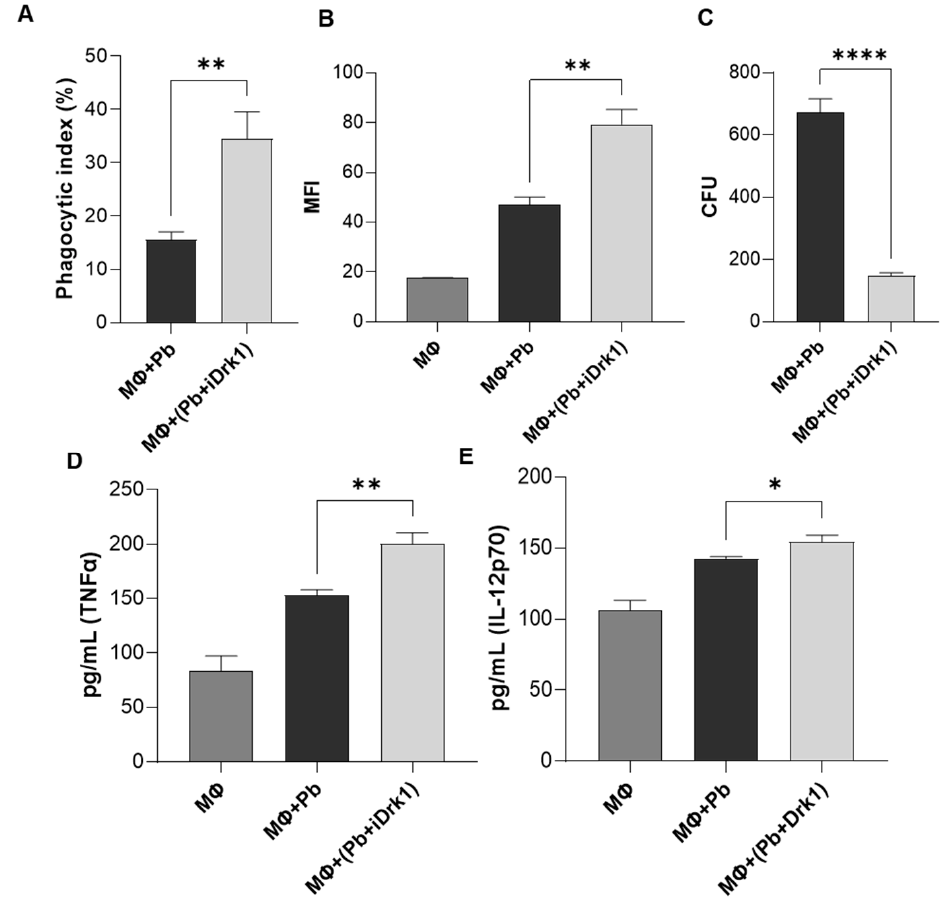
Figure 4. Phagocytosis assay. 2.5 × 10 5 J774 cells (M Φ ) were plated in RPMI medium supplemented with 10% FBS. Then the cells were primed for 30 min with LPS 100 ng/mL. In parallel, P. brasiliensis yeasts were subjected to 25 µ g/mL of iDrk1 for 24 h. The interaction was carried out in a 2:1 ratio (yeast:macrophages) for 24 h at 37 ◦ C and 5% CO 2 . After this period, the cells were stained and visualized under an optical microscope to count the internalized yeasts. ( A ) Phagocytic index was calculated, where p -value ≤ 0.005 (**). ( B ) Phagocytosis assay performed by labeling P. brasiliensis yeasts with CFSE prior to interaction with macrophages. Fluorescence quantification was performed by flow cytometry and relative quantification was obtained through the median intensity (MFI) where p -value ≤ 0.005 (**). ( C ) CFU determination from yeasts recovered from macrophages, where p -value ≤ 0.0001 (****). Cytokine assay from J774 cell supernatant after inter- action with P. brasiliensis submitted or not with iDrk1. Macrophages were plated in RPMI medium supplemented with 10% FCS. Then, cells were primed for 30 min with LPS 100 ng/mL. In parallel, P. brasiliensis yeasts were subjected to 25 µ g/mL of iDrk1 for 24 h. The interaction was carried out in a 2:1 ratio (yeast:macrophages) for 24 h at 37 ◦ C and 5% CO 2 . After this period, the supernatant was collected and the cytokines ( D ) TNF α , ( E ) IL-12p70 were measured, where p -value ≤ 0.05 (*), p -value ≤ 0.01